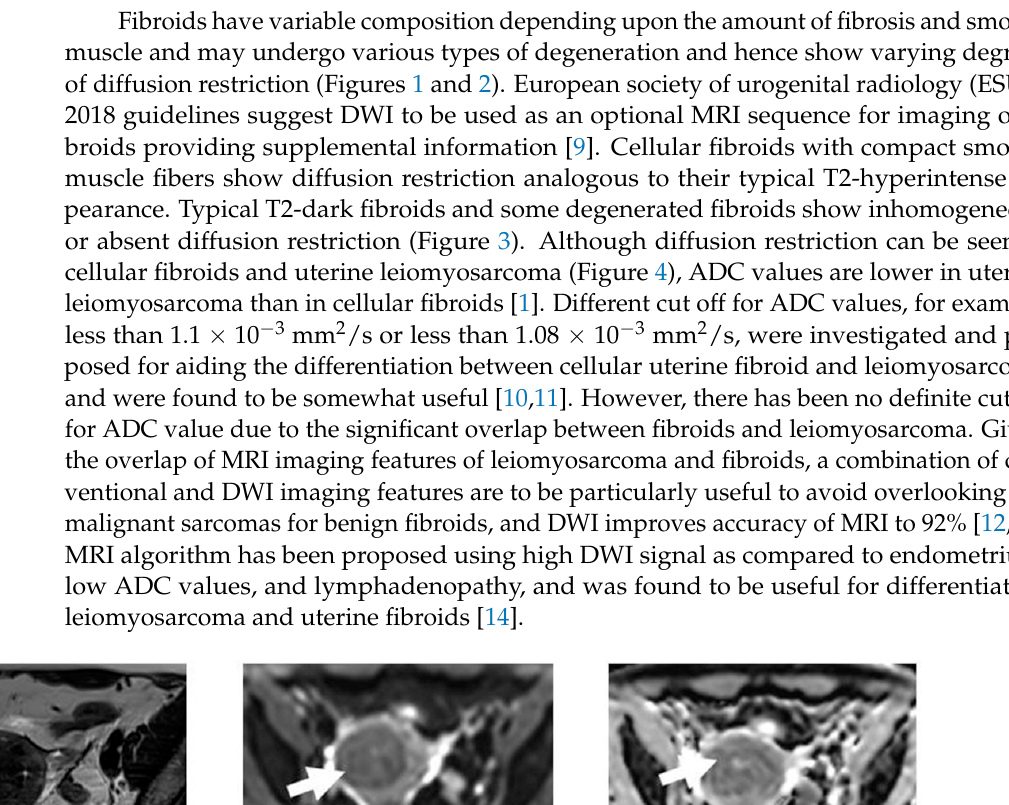
Figure 3. Axial T2-weighted ( a ), contrast-enhanced T1-weighted ( b ), DWI ( c ), and ADC map ( d ) image shows a large T2 heterogenous uterine fibroid with peripheral cellular area showing diffusion restriction (arrows) and central T2 hyperintense non-enhancing area without diffusion restriction in the degenerated portion (asterisk) of the fibroid. Figure 4. Axial ( a ) and sagittal ( b ) T2-weighted, axial contrast-enhanced T1-weighted ( c ), DWI ( d ), and ADC map ( e ) images of the pelvis showing bulky irregular enhancing anterior uterine wall